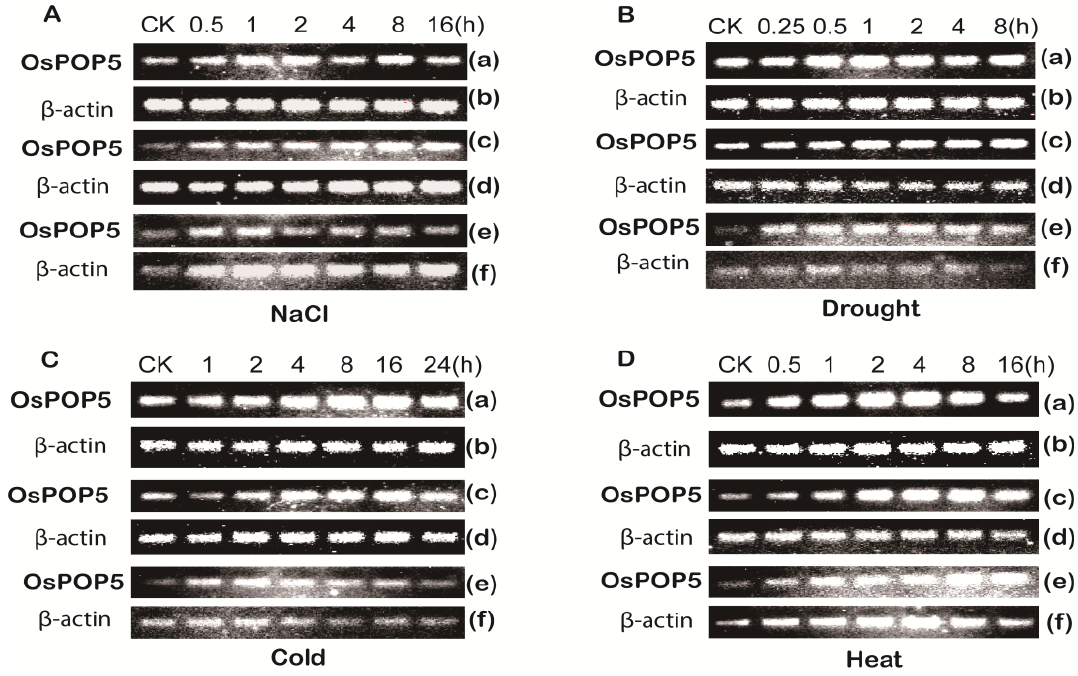
Figure 4. Expression analysis of OsPOP5 under various abiotic stress treatments in different tissues. The expression analyses were performed by total RNA extracted from leaves ( a and b ), stems ( c and d ) and roots ( e and f ) of rice at marked time after treatment with ( A ) NaCl; ( B ) drought; ( C ) cold; ( D ) heat; ( E ) indole-3-acetic acid (IAA); ( F ) abscisic acid (ABA); and ), respectively. The β -actin was used as standard control to show the ( G ) gibberellin (GA 3 normalization of amount of template PCR